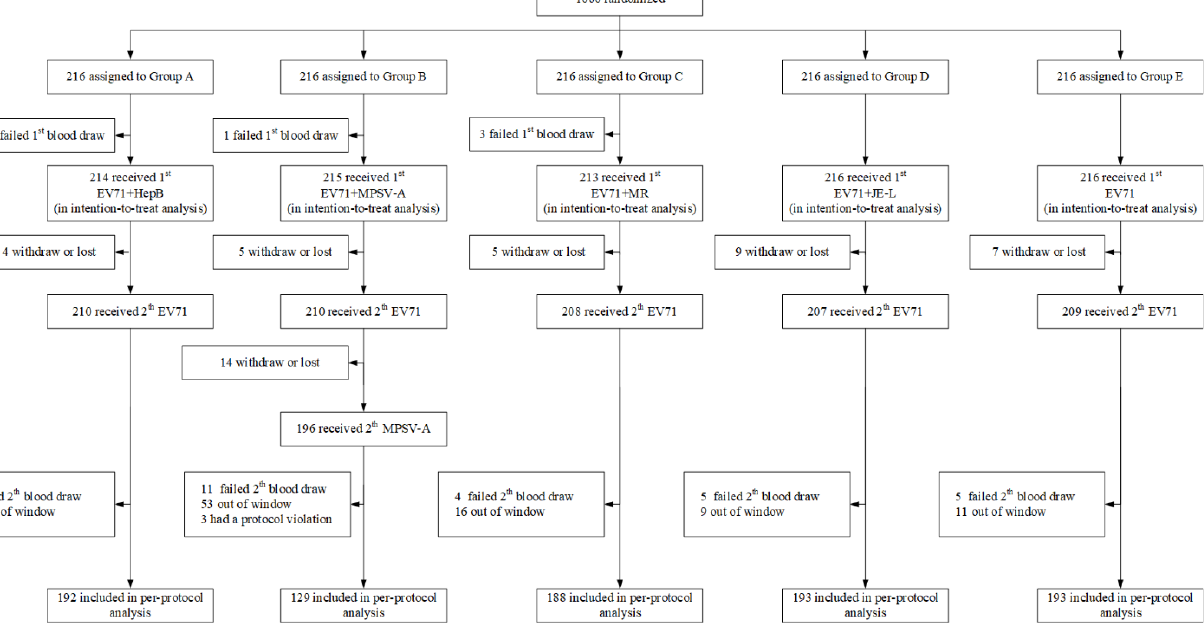
Figure 2. Trial profile, per ‐ protocol analyses (PPS), China, 2018 to 2019. Table 1. Baseline characteristics in total populations and per ‐ protocol populations.